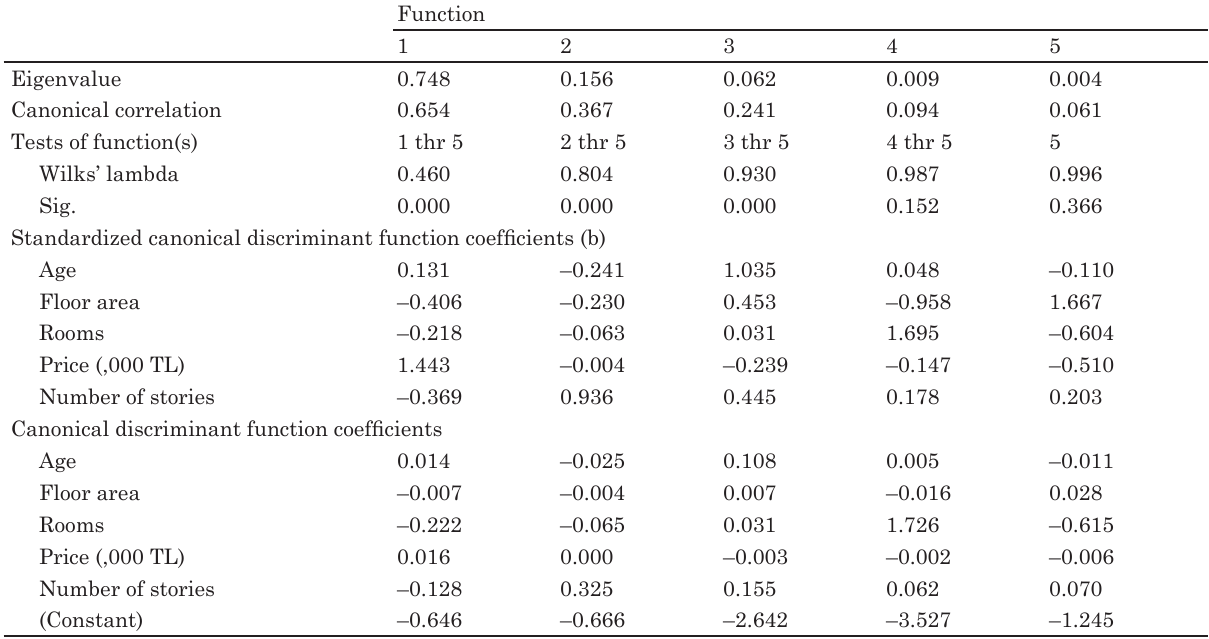
Table 6. Eigenvalues, canonical correlations, Wilks’ lambda, coefficients discriminant functions